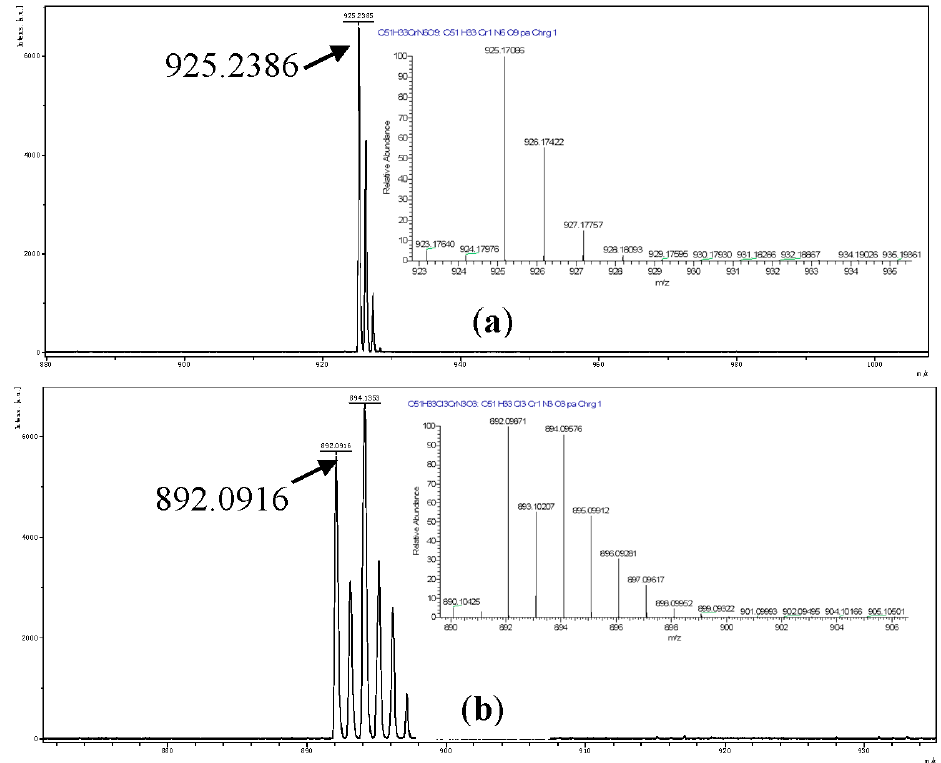
Figure 7. MALDI-TOF mass spectra of mononuclear complexes of Cr( L 1 ) 3 ( a ) and Cr( L 2 ) 3 ( b ), the insert pictures are the calculated MS spectra of 1 and 2 , respectively.